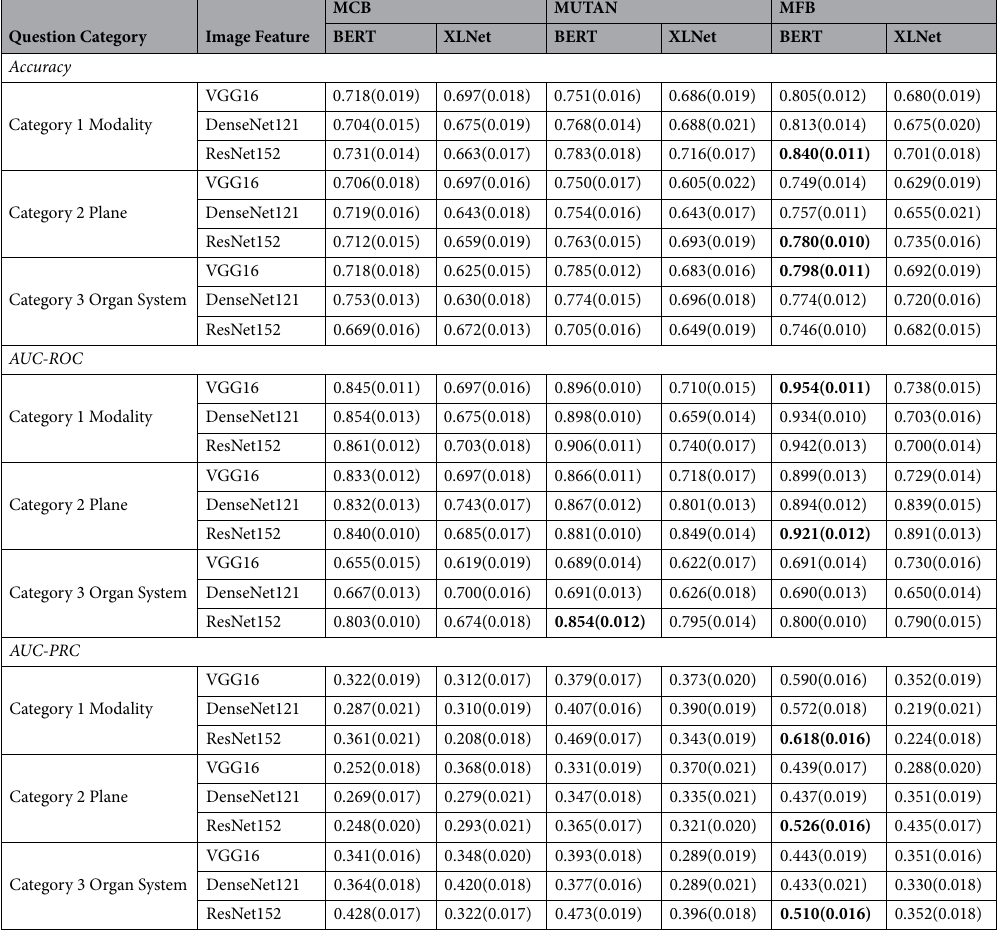
Table 7. Performance metric scores for the ablation study experiments on MED-VQA